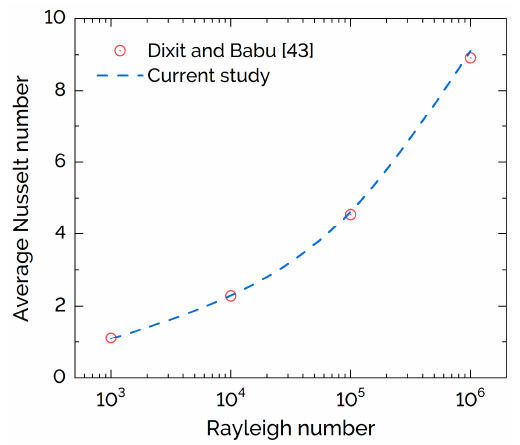
Figure 2. Estimated average Nusselt number of the present study with the benchmark solution of Dixit and Babu [43].